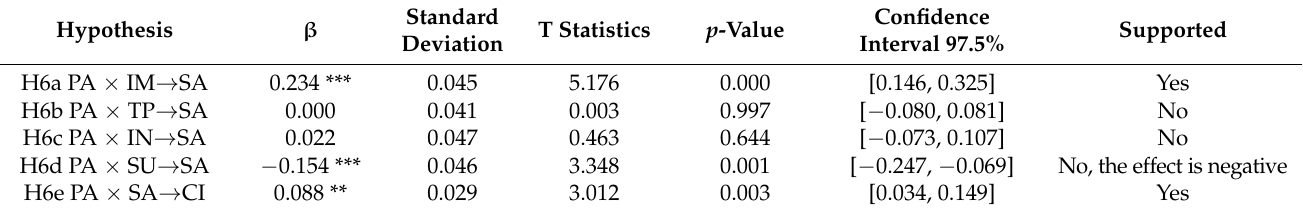
Table 7. Moderation